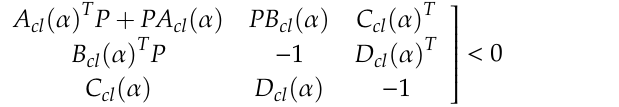
Figure 14. Step responses with the modified H ∞ LPV controller.